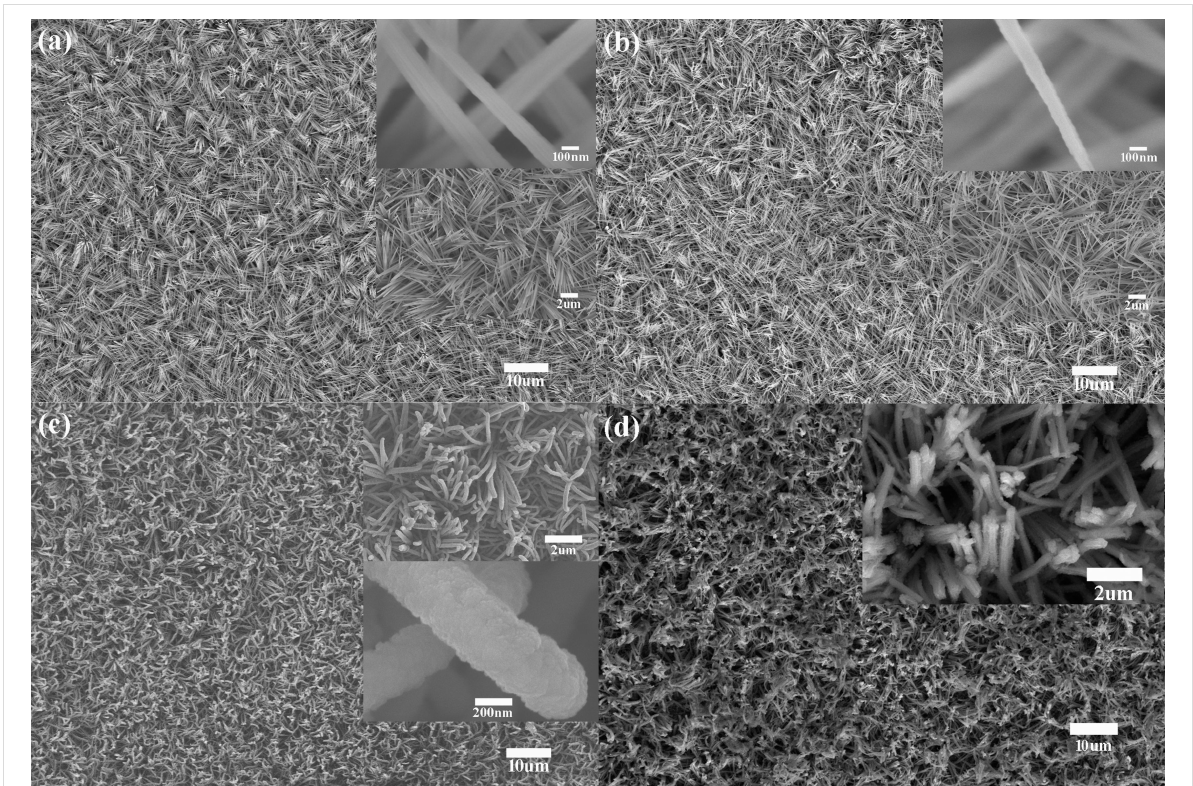
Figure 5: Top view SEM images of the (a) Cu(OH) 2 nanorods, (b) CuO nanorods, and (c) Si anode supported on CuO nanorods and (d) Si anode after 50 cycles.